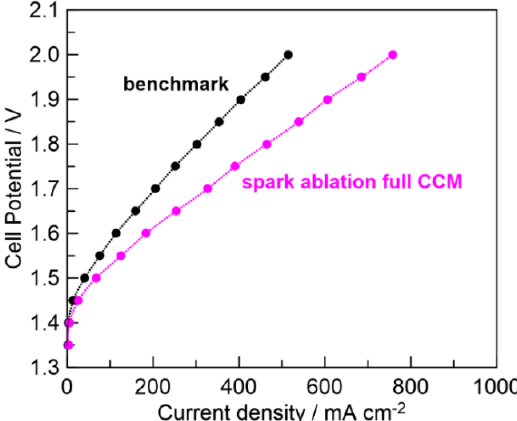
Figure 4. Polarization curves at 60 °C obtained with the spark-ablation fully coated CCM (0.8 mg Ir cm −2 , 0.5 mg Pt cm −2 ) and the commercial CCM (benchmark, 2 mg IrRuO x cm −2 , 4 mg Pt cm −2 ).